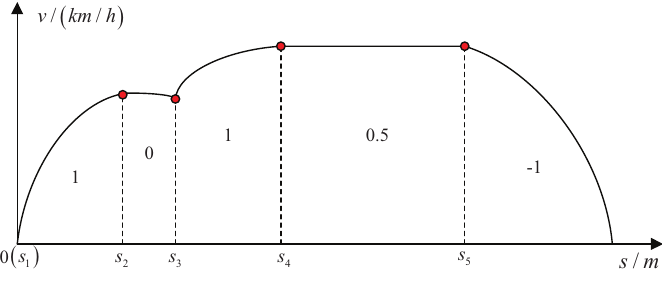
Figure 4. Schematic diagram of the train control